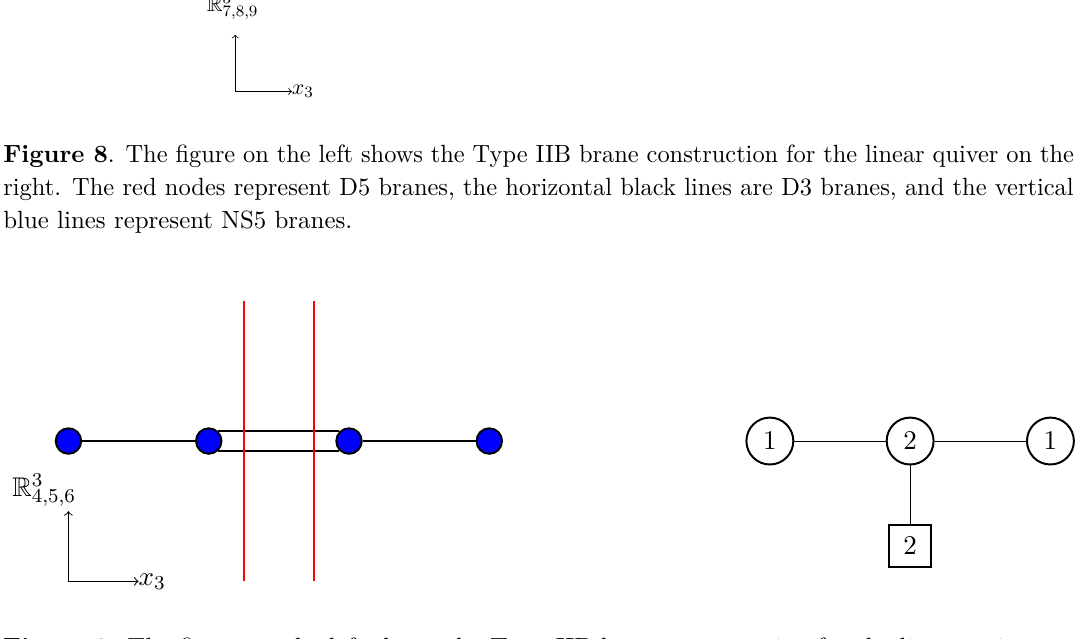
Figure 9 . The figure on the left shows the Type IIB brane construction for the linear quiver on the right. The blue nodes represent NS5 branes, the horizontal blck lines are D3 branes, and the vertical red lines represent D5